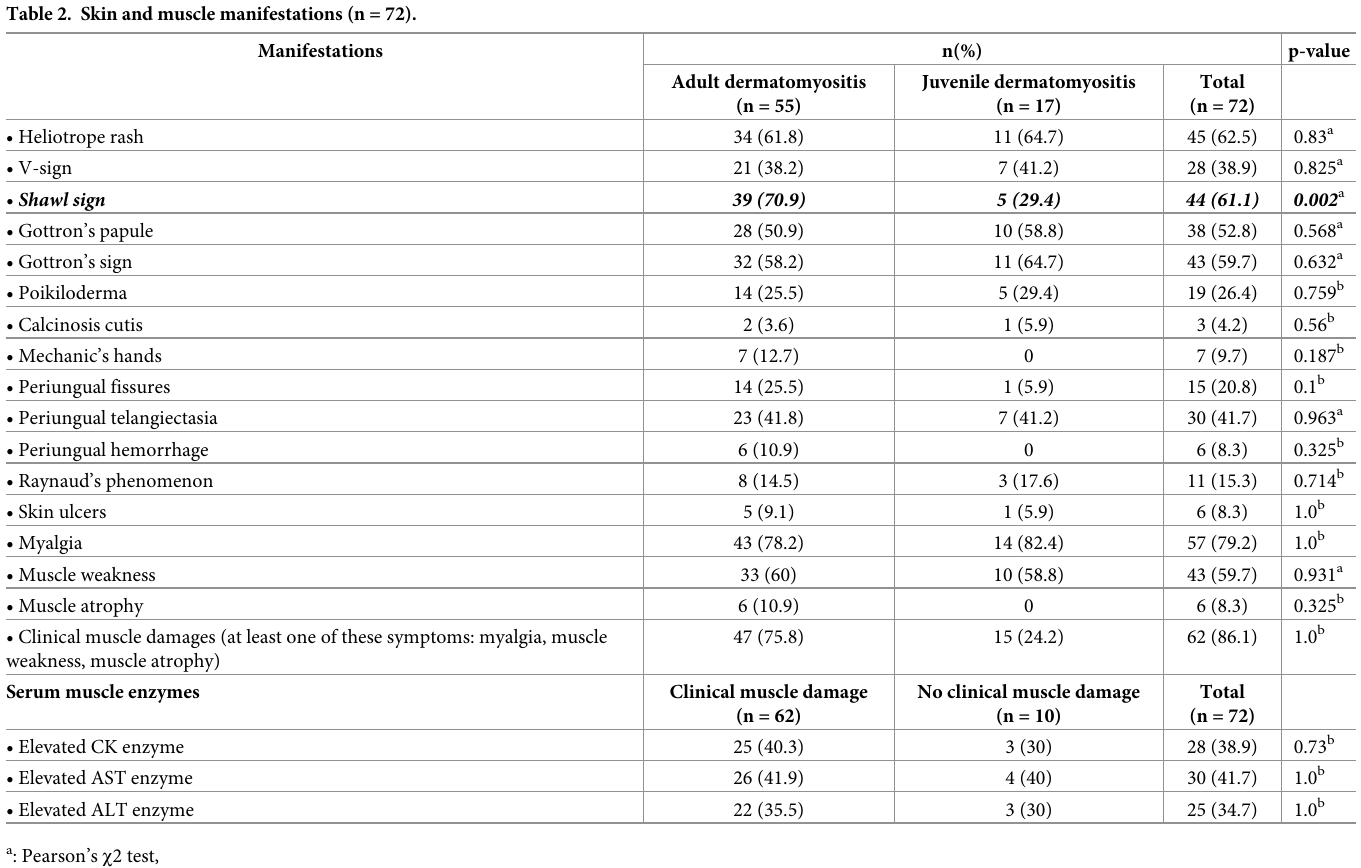
Table 2. Skin and muscle manifestations (n =